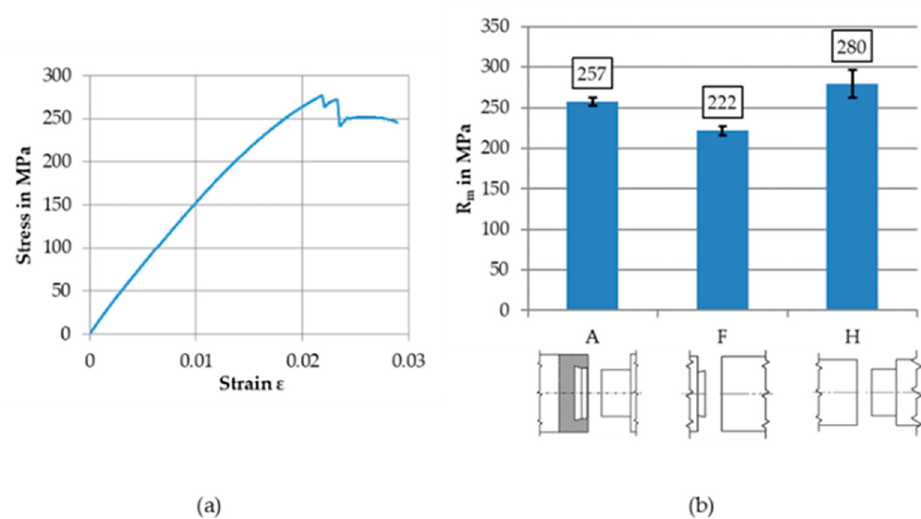
Figure 5. ( a ) stress–strain curve of Geometry A; ( b ) schematic drafts of the specimen geometries featuring the highest tensile strengths values with the standard deviation.